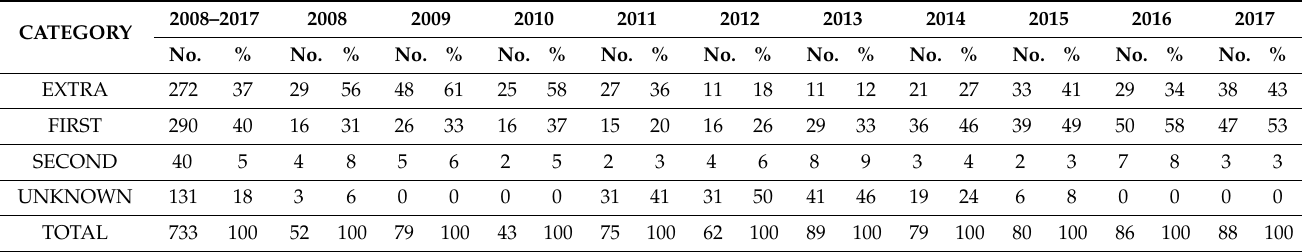
Table 3. Samples by